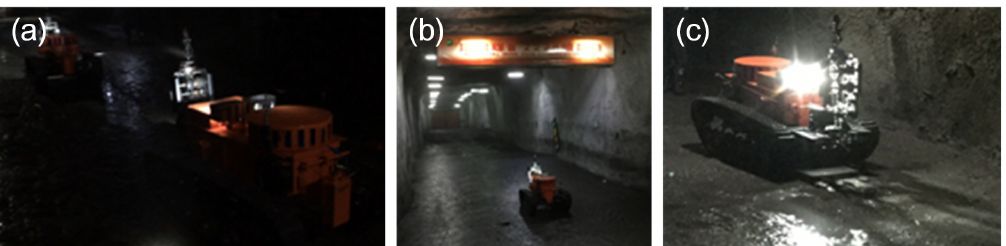
Figure 27. ( a ) shows that two robots are traveling in series in the coal mine in the semiautomatic control mode; ( b , c ) show that the robot is moving forward in the coal mine in the semiautomatic control mode with the v f – ∆ θ f method.